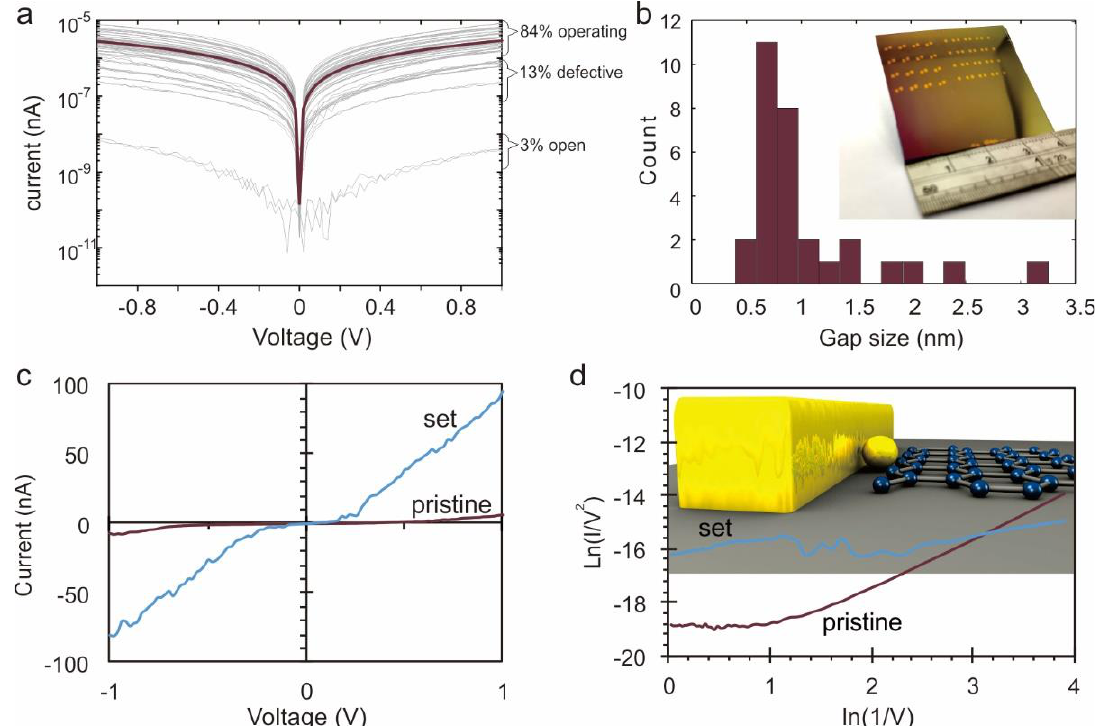
Figure 4. Scalability of nanogap formation approach and applications. ( a ) Overlay of 30 IVs obtained from one sample with the indication of status; ( b ) histogram of gap sizes throughout the sample indicating that 70% of devices exhibit gaps within a 0.5 nm range, (inset) photograph of sample; ( c ) realization of atomic-scale memory showing distinct IV before and after writing step, (inset) tunneling mechanism in pristine and set cases; ( d ) FN plots of pristine and set memory states, (inset) depiction of set state.